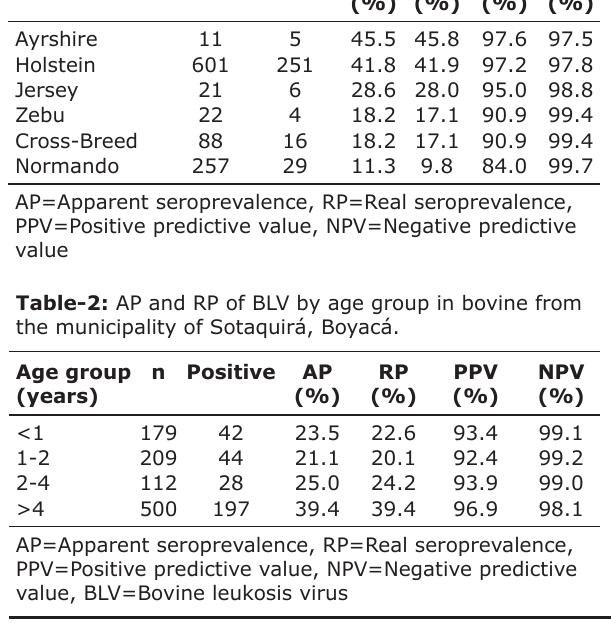
Table-1: AP and RP of BLV by bovine breed in Sotaquirá, Boyacá. Breed